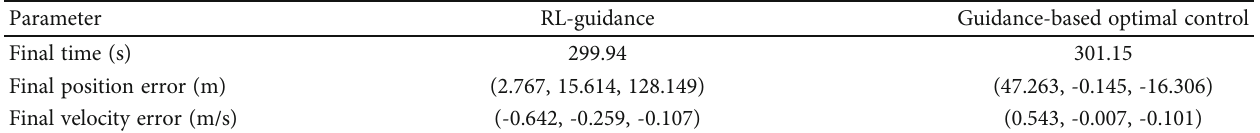
Table 3: Results of RL-guidance and guidance-based optimal control.